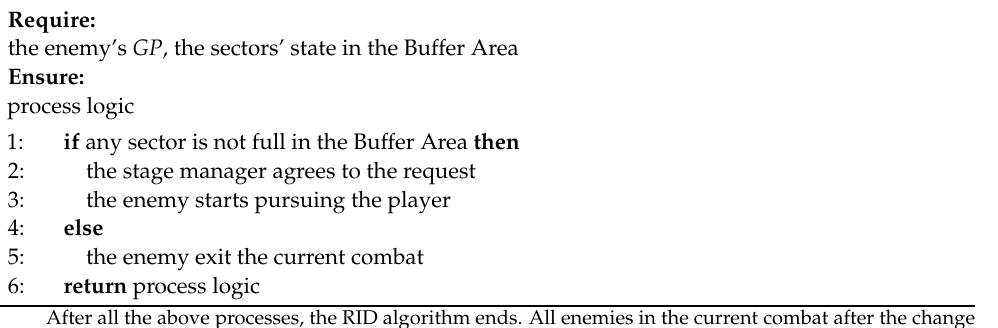
Algorithm 4 IBAI-RID Algorithm-Pursue Requests